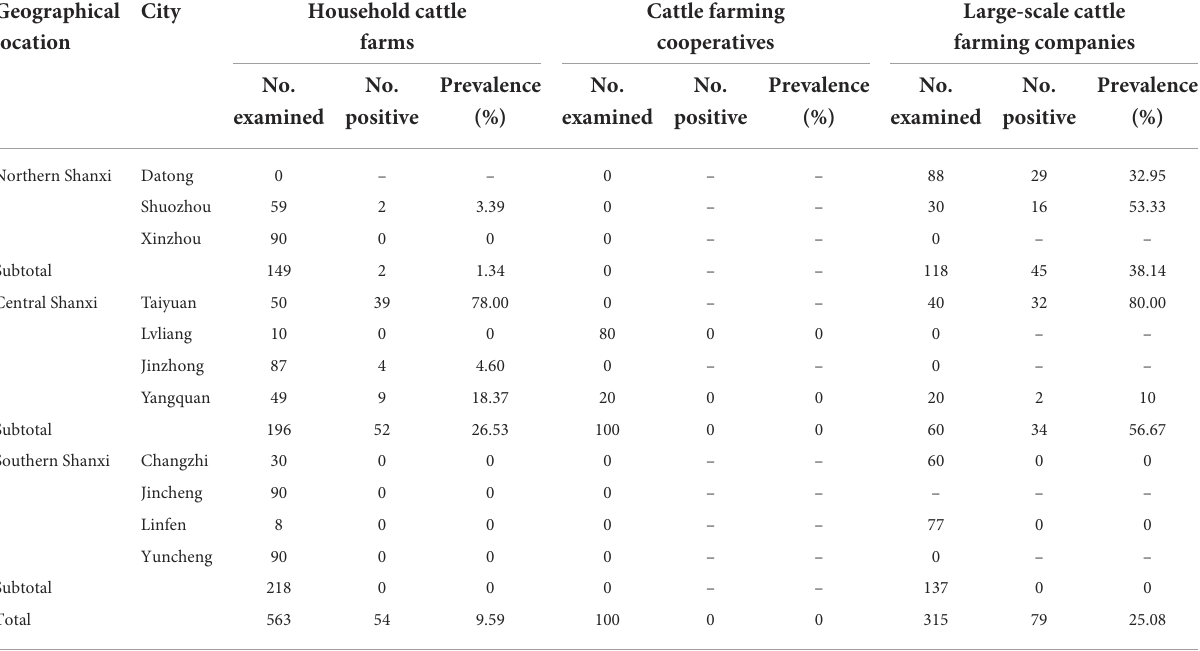
TABLE 3 The seroprevalence of N. caninum in cattle for the three management modes between different cities in each region in Shanxi Province. Geographical City